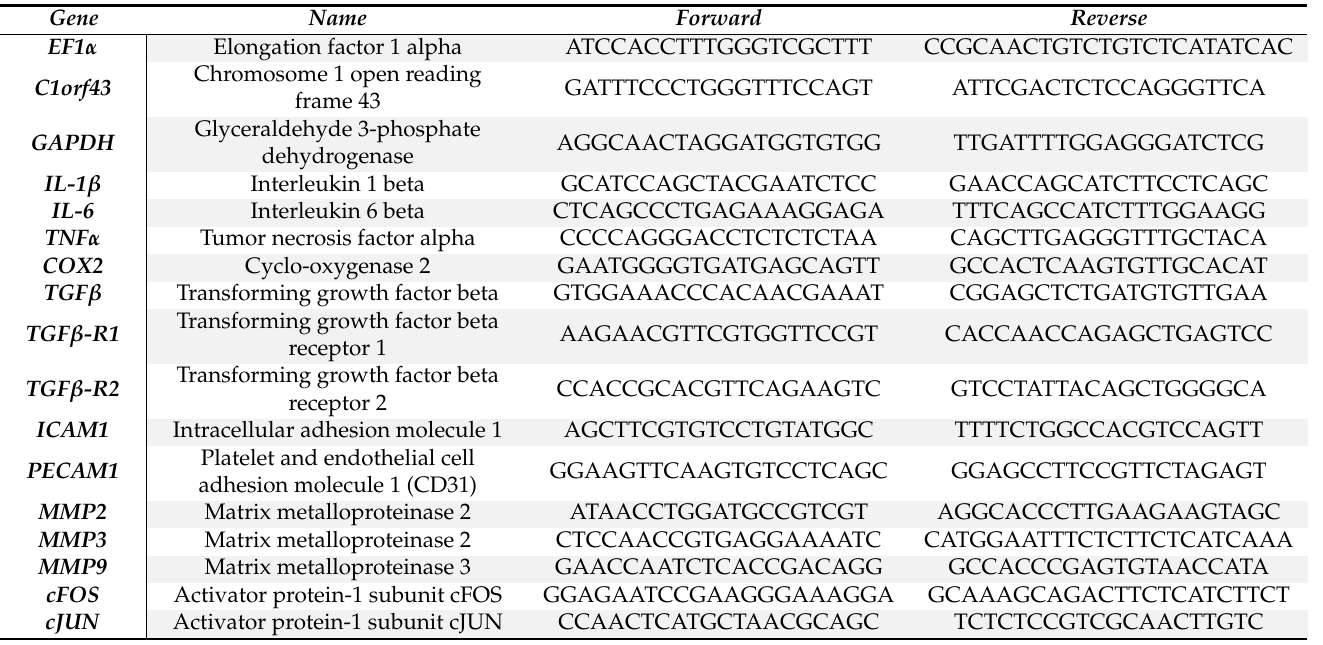
Table 1. Primers used for quantitative real-time